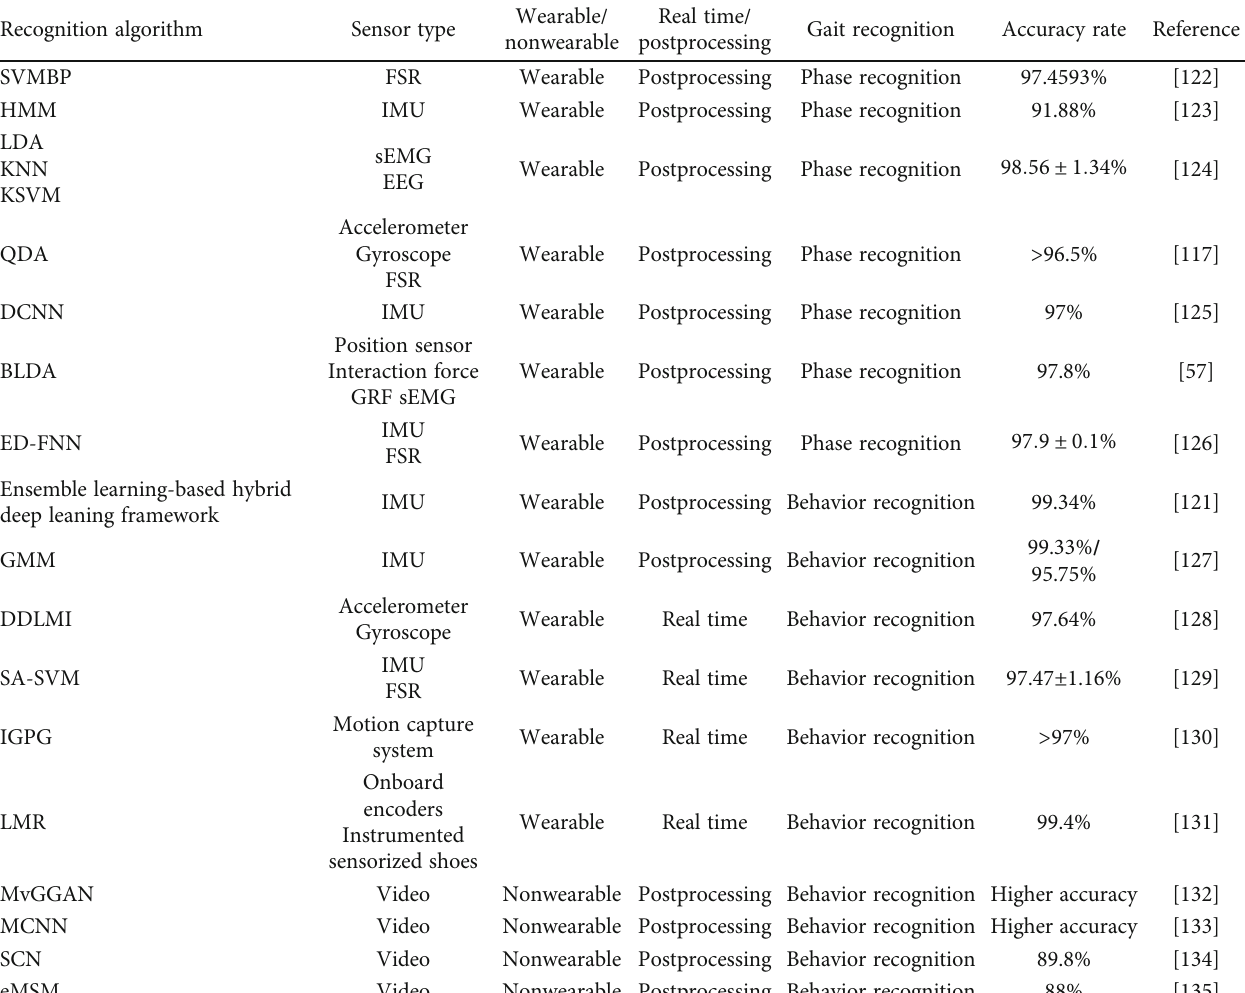
Table 4: Gait recognition methods of lower limb exoskeleton